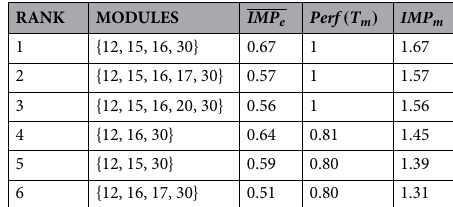
Table 1. Detected modules from the Barabasi network shown in Fig.